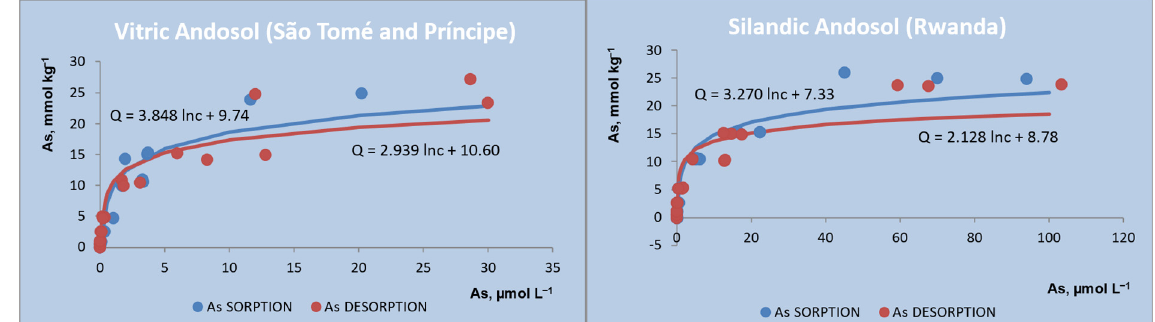
Figure 5. As sorption and desorption isotherms (sorbed As (mmol kg − 1 ) vs. As concentration in the equilibrium solution (µmol L − 1 )) fitted to the Temkin model.